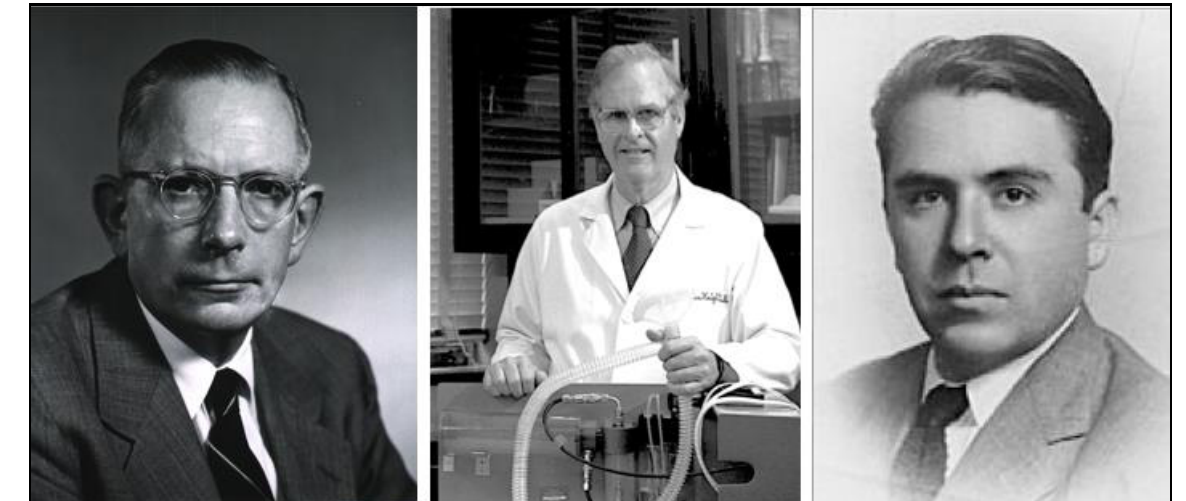
Figure 10. The Clinical Investigators. Left. Joseph E. Smadel MD of the Walter Reed Army Medical Center and the NIH. Smadel, Herbert Ley Jr., and Theodore E. Woodward first treated FBT patients with chloramphenicol. In 1962, Smadel received the Albert Lasker Clinical Medical Research Award “for outstanding contributions to the understanding, diagnosis, and treatment of virus and rickettsial diseases . . . ” [174]. Center. Vernon Knight MD. Along with Francisco Ruiz-Sanchez, Amado Ruiz-Sanchez, and Walsh McDermott, Knight conducted the first trial of chlortetracycline against FBT [171]. Right. Francisco Ruiz-Sanchez MD [175].